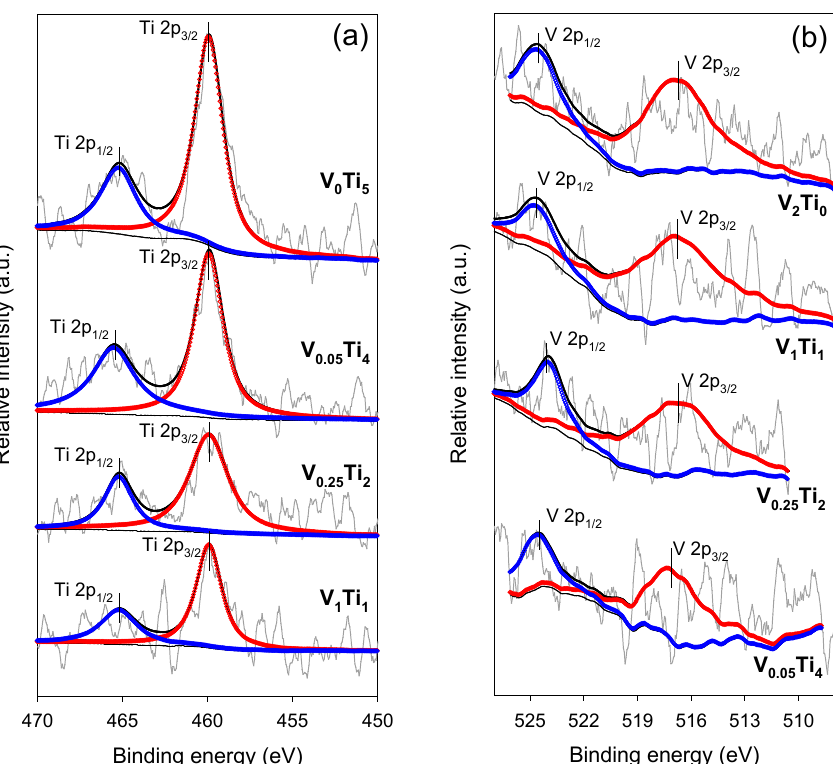
Figure 3. UV-vis spectra of the series V-Ti/MCM-41 catalysts.